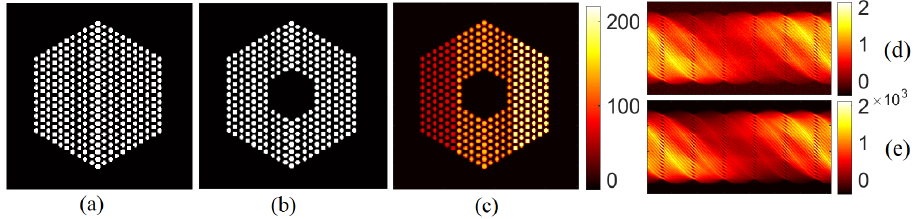
Figure 2. Simulated dataset. ( a ) The admissible support, ( b ) original binary mask, ( c ) ground truth activity profile when the peak value is set to 220, ( d ) sinogram generated with an iid Gaussian noise model with peak value = 220 and noise variance σ 2 = 2 × 10 − 3 , and ( e ) sinogram generated with a Poisson noise model with peak value =